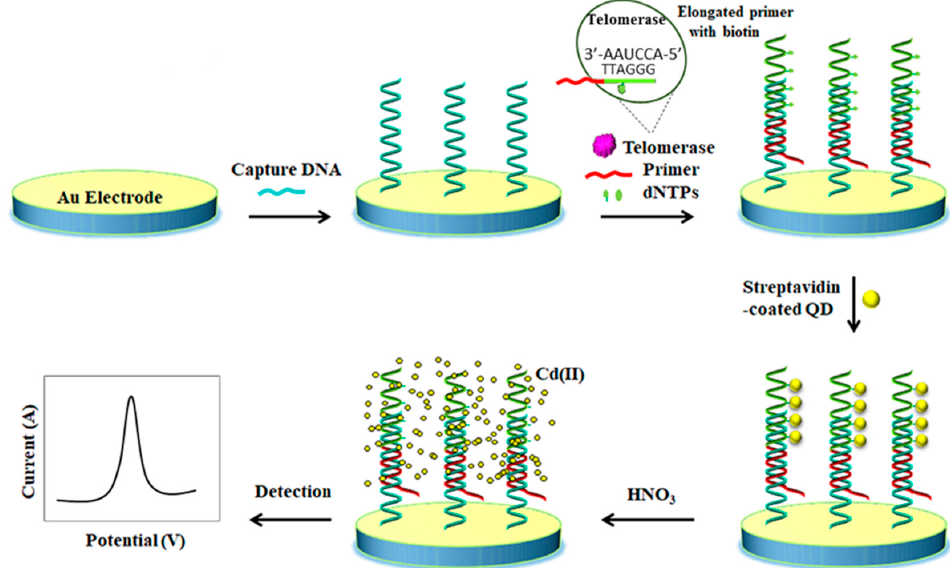
Figure 6. Schematic illustration of a QD-based electrochemical biosensor for the stripping voltammetric detection of telomerase activity. Reproduced and adapted from [52] with permission.